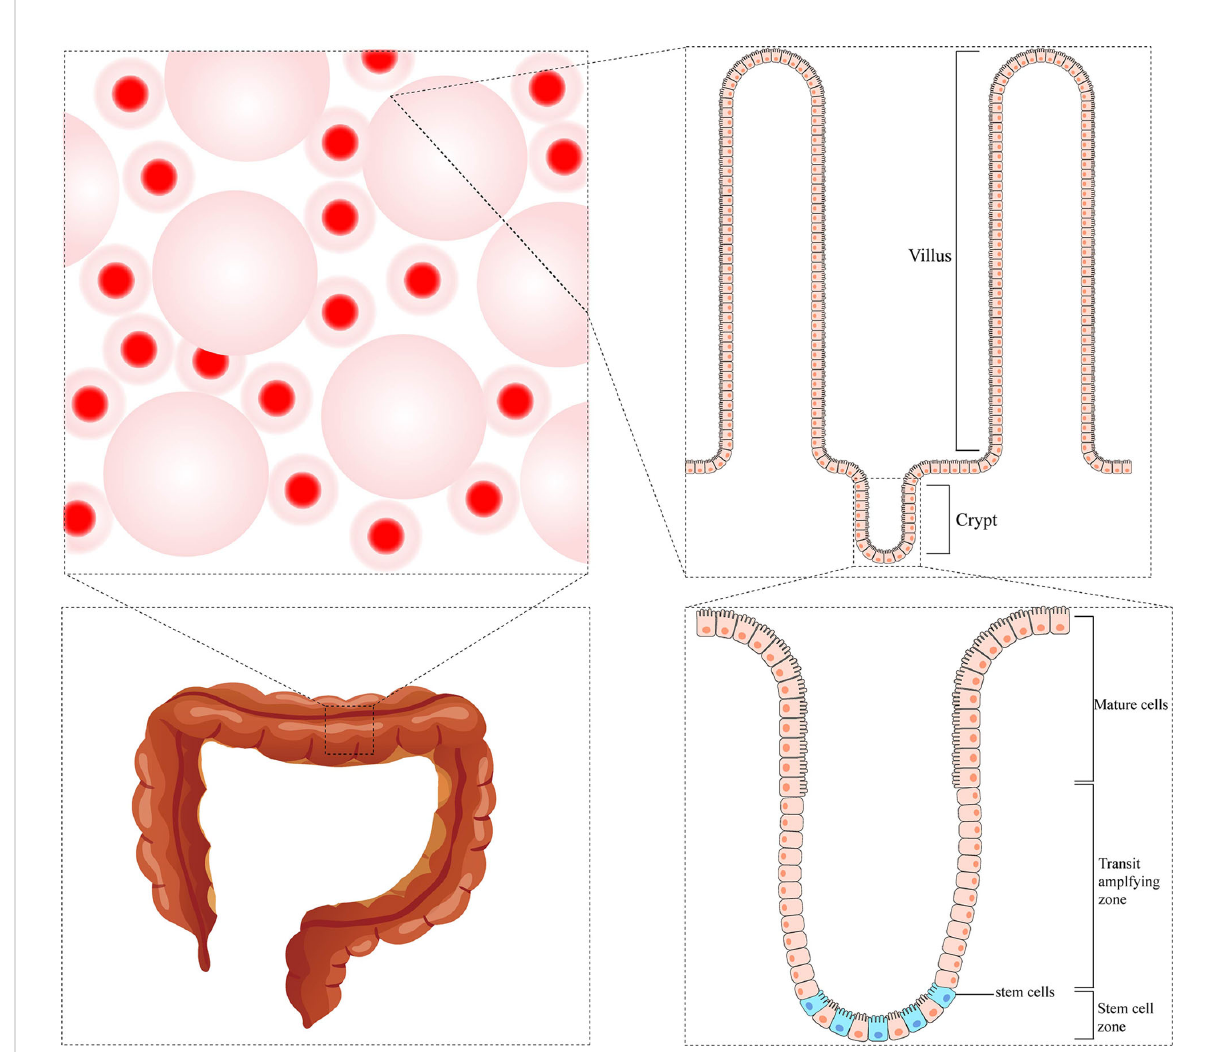
FIGURE 1 The microstructure of colonic